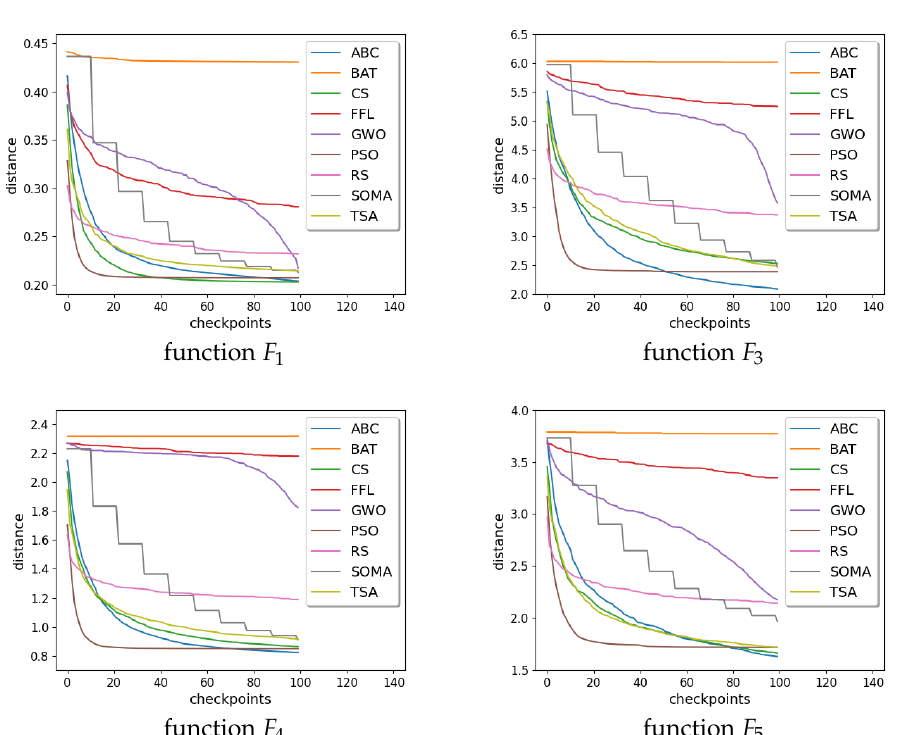
Figure 4. Graphs of distance convergence means for maxFES =